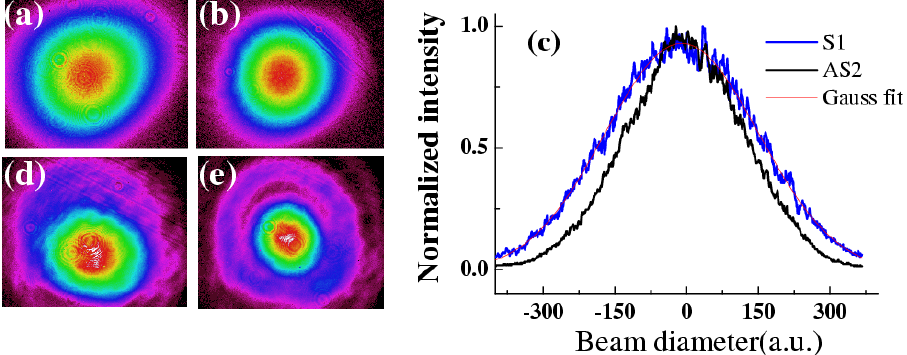
Figure 15. The two-dimensional spatial modes of (a) S1 and (b) AS3. (c) The one-dimensional spatial profiles of S1 and AS3, together with a Gaussian fit to S1. The two-dimensional spatial mode of beam2 (d) when beam1 was blocked and (e) when the input power of beam1 was 20 mW